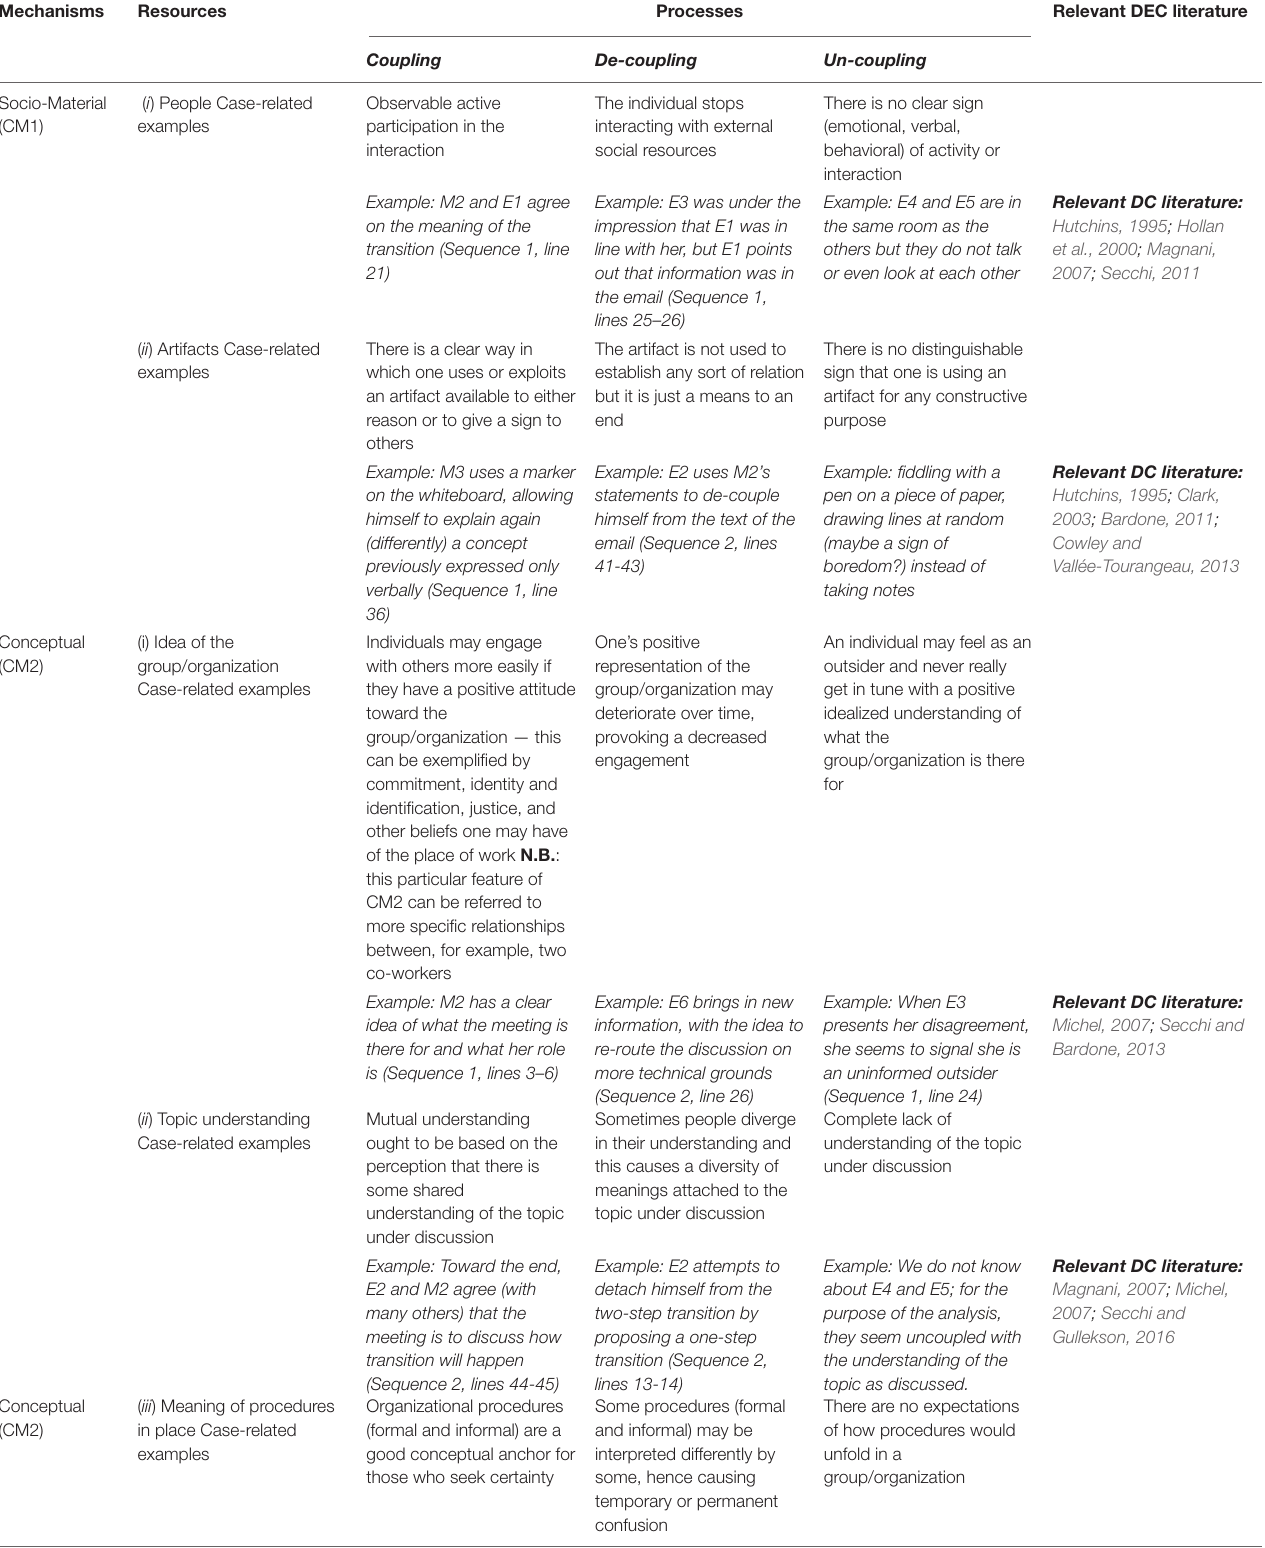
TABLE 1 | Cognitive mechanisms, resources, and processes.